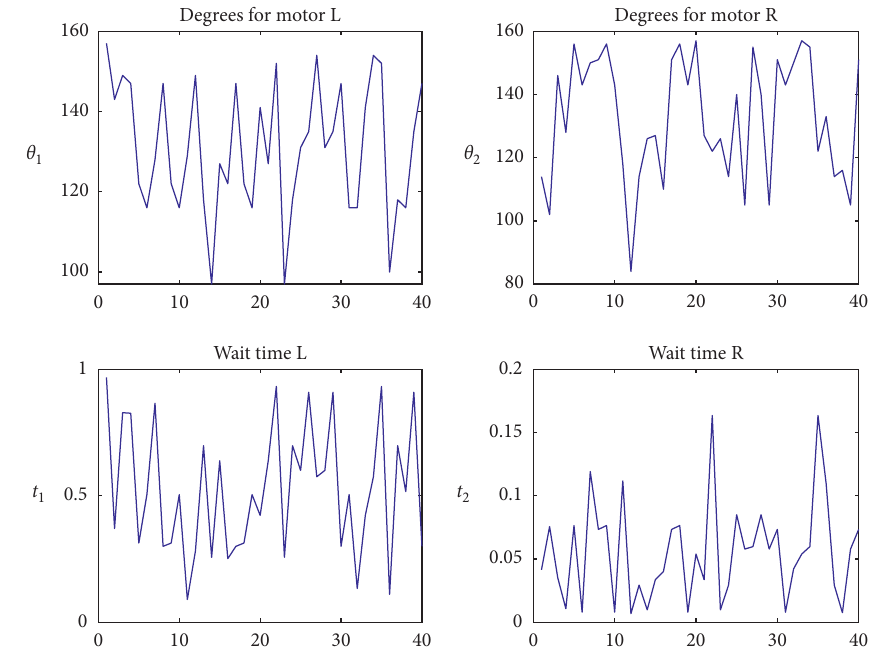
Figure 16: Maximum actuator values for ( θ